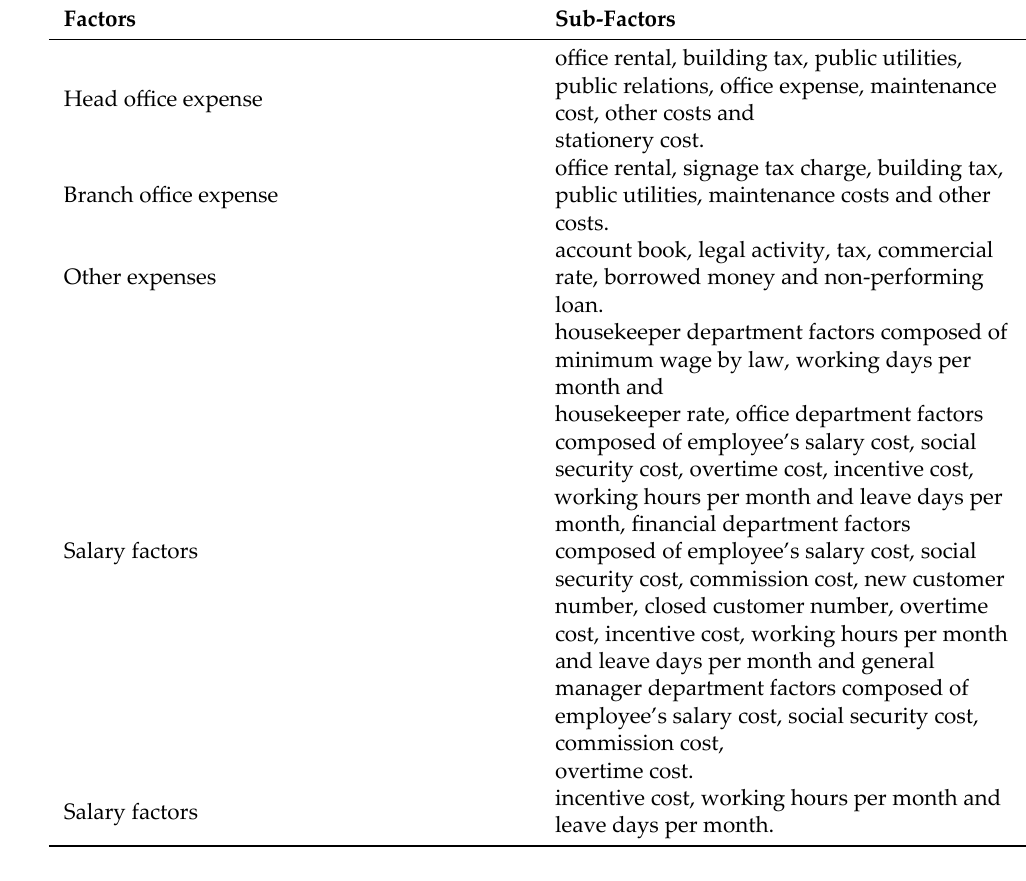
Table 8. Expense factors for hybrid decision model.